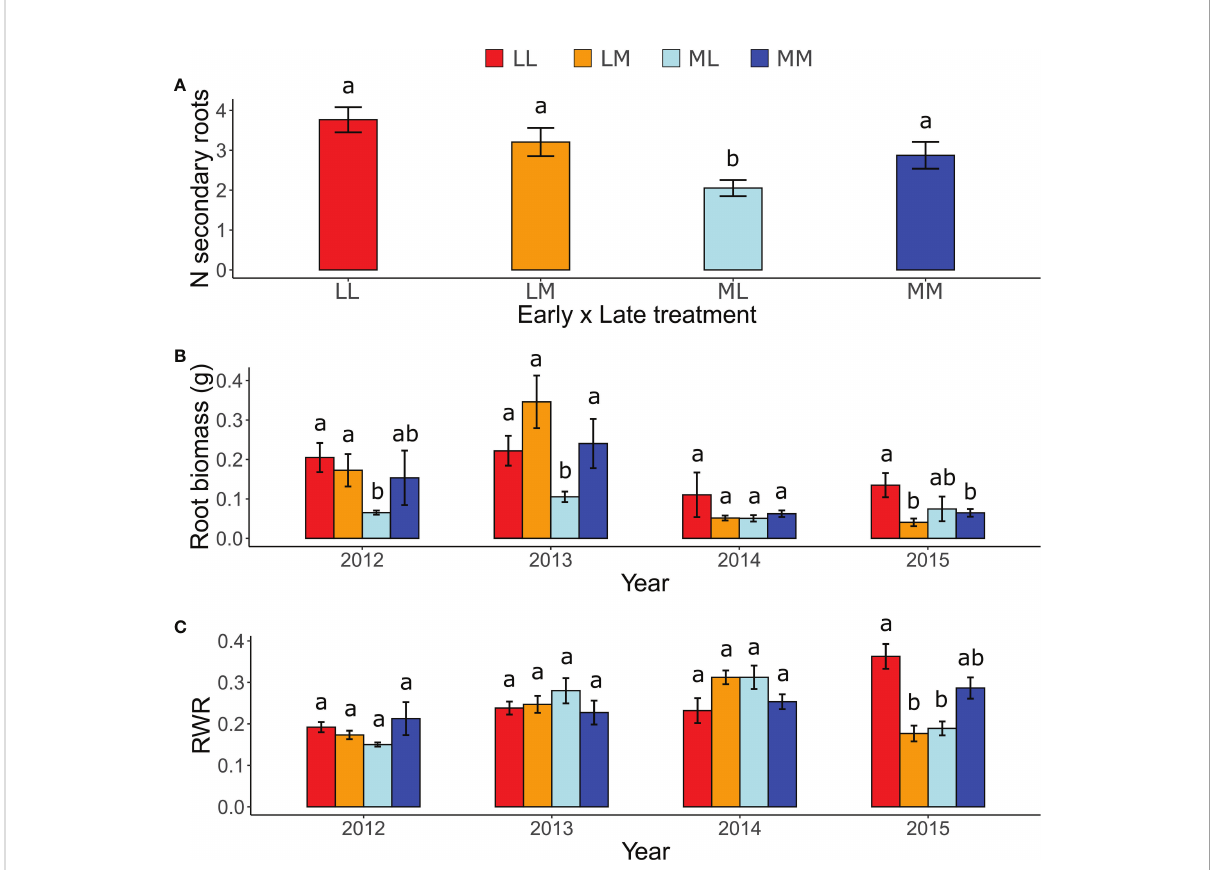
FIGURE 2 Effects of inter-seasonal predictability on the number of secondary roots, root biomass and root weight ratio (RWR) of ancestors. Interaction between: (A) Early treatment × Late treatment on the number ( N ) of secondary roots; (B) Early treatment, Late treatment, and Year on root biomass; and (C) Early treatment, Late treatment, and Year on RWR. Means ± SE are shown in the bar plots. Signi fi cant post-hoc contrasts among treatment combinations (and among treatments within the same year in B and C) are indicated with